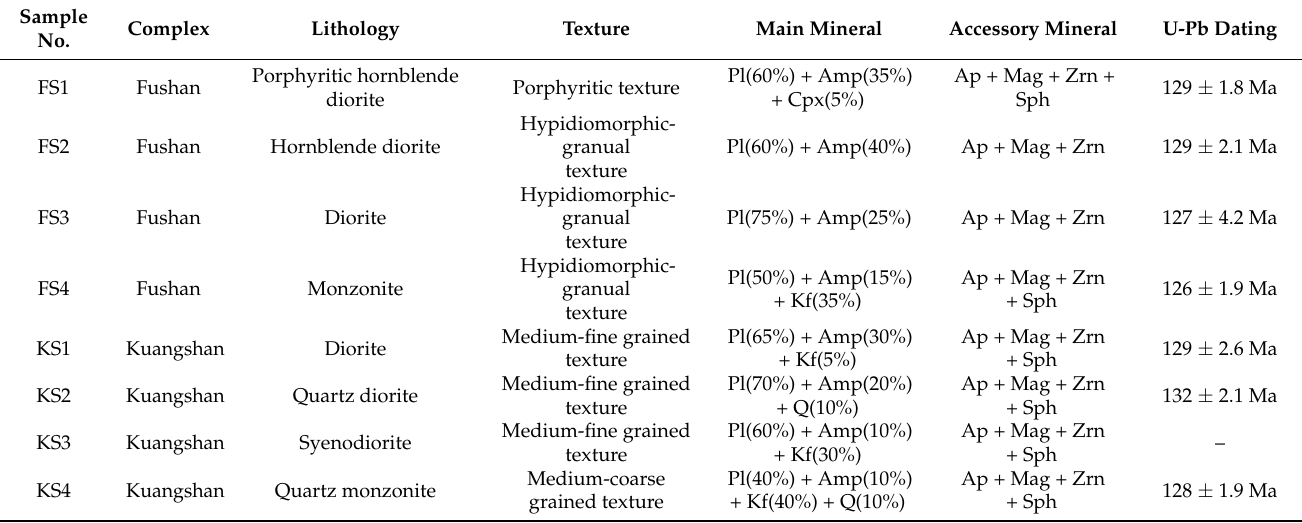
Table 1. Comparison of the sample features in the Fushan and Kuangshan complexes. Sample